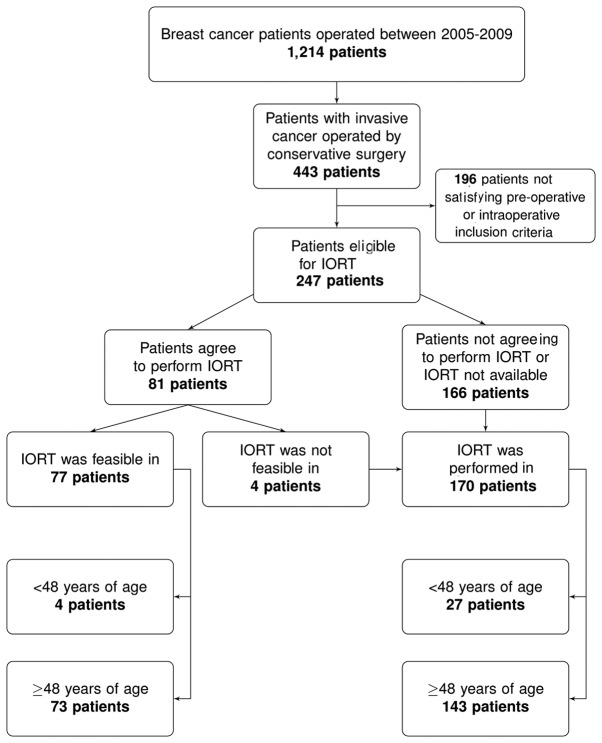
Study flow-chart.